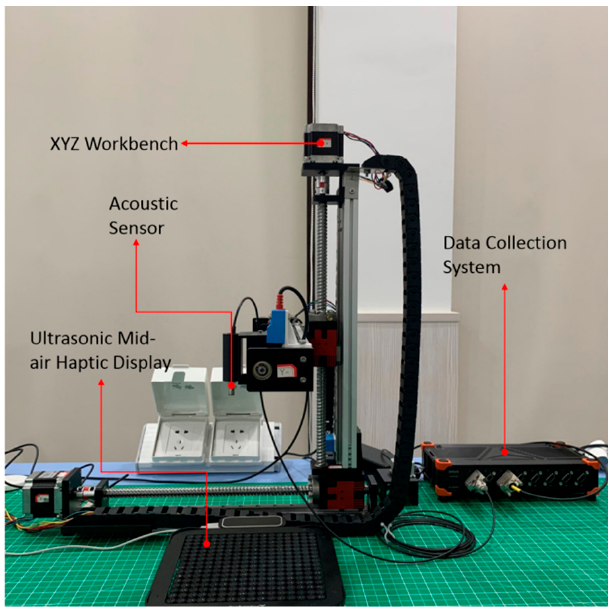
Figure 4. Measurement setup: XYZ workbench, data collector, acoustic sensor, ultrasonic mid-air haptic